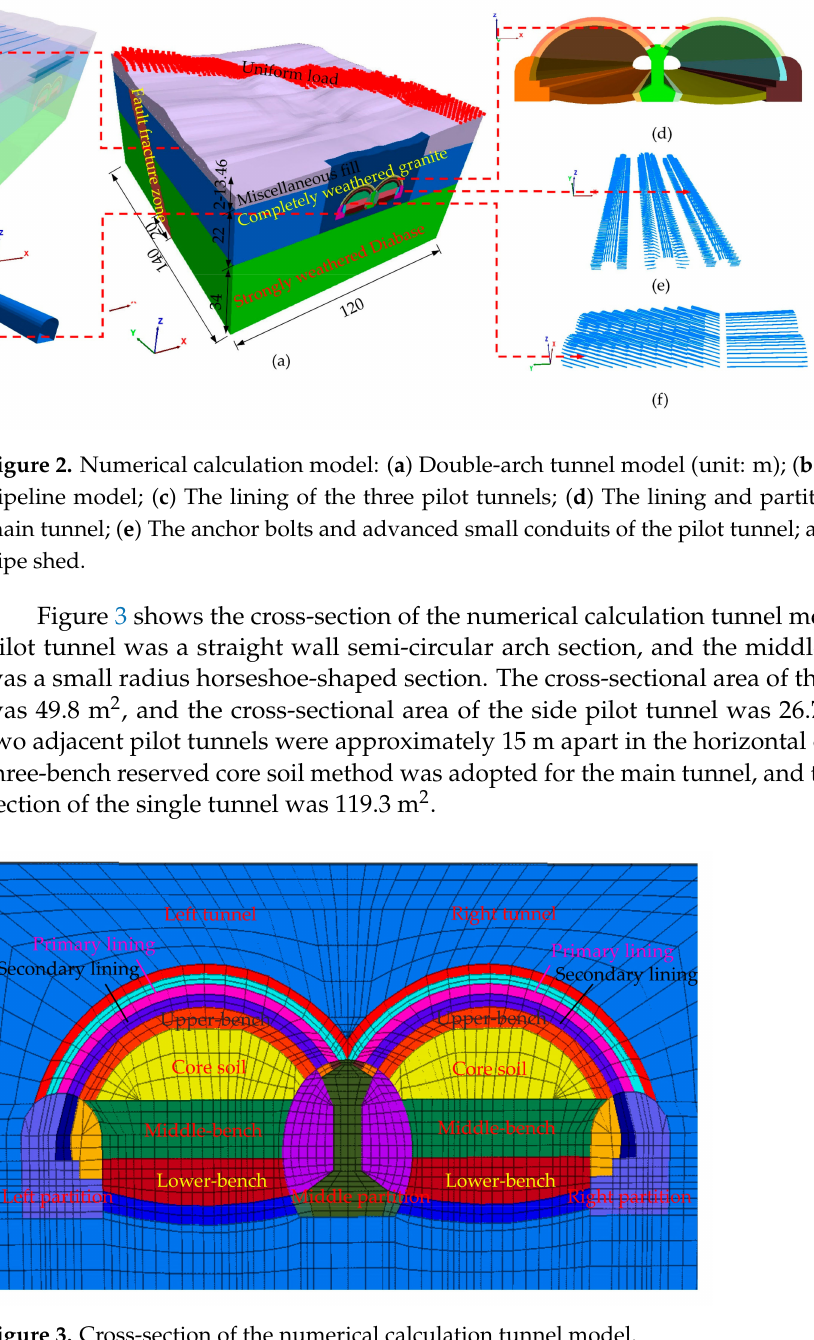
Figure 3. Cross-section of the numerical calculation tunnel